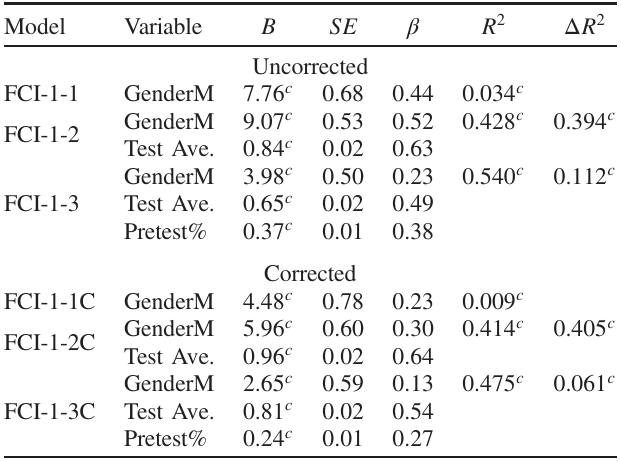
TABLE V. Hierarchical linear regression for the FCI (sample FCI-1). The superscript c denotes p < 0 . 001 .